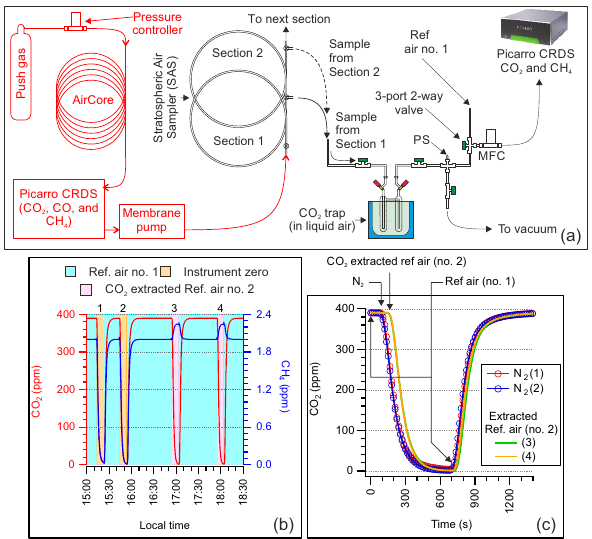
Figure 2. (a) Schematic of the sample transfer procedure from the AirCore into the SAS (marked in red) and the extraction system used for the extraction of CO 2 from stratospheric air contained in the SAS. The CO 2 trap was submerged in a liquid air bath, which al- lowed quantitative freezing of CO 2 and avoided co-freezing of CH 4 and O 2 . Using a CRDS analyzer (Picarro G2301), the concentration of CH 4 in the CO 2 -extracted air was determined. The components indicated with abbreviations are as follows: MFC, mass flow con- troller; PS, pressure sensor. (b) An example time series showing a control sampler filled consecutively with N 2 (instrument zero, first two shown with an orange background) and reference air (no. 2, CO 2 -extracted, last two shown with a pink background) to evalu- ate the extraction efficiency at a flow rate of 3sccm. Reference air (no. 1) is directed through the Picarro analyzer when the extraction system is being made ready for the next extraction (shown with a cyan background). (c) Superimposed CO 2 signal during the intro- duction of the zero gas (N 2 ) and the CO 2 -extracted reference air (no. 2) showing a near-100% extraction